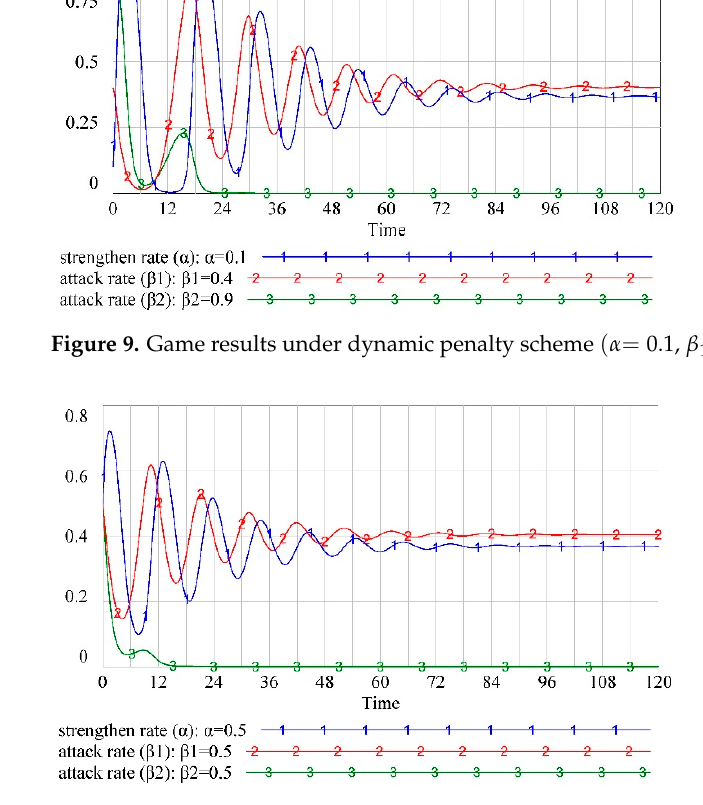
Figure 10. Game results under dynamic penalty scheme ( α = 0.5, β 1 = 0.5, β 2 = 0.5 )